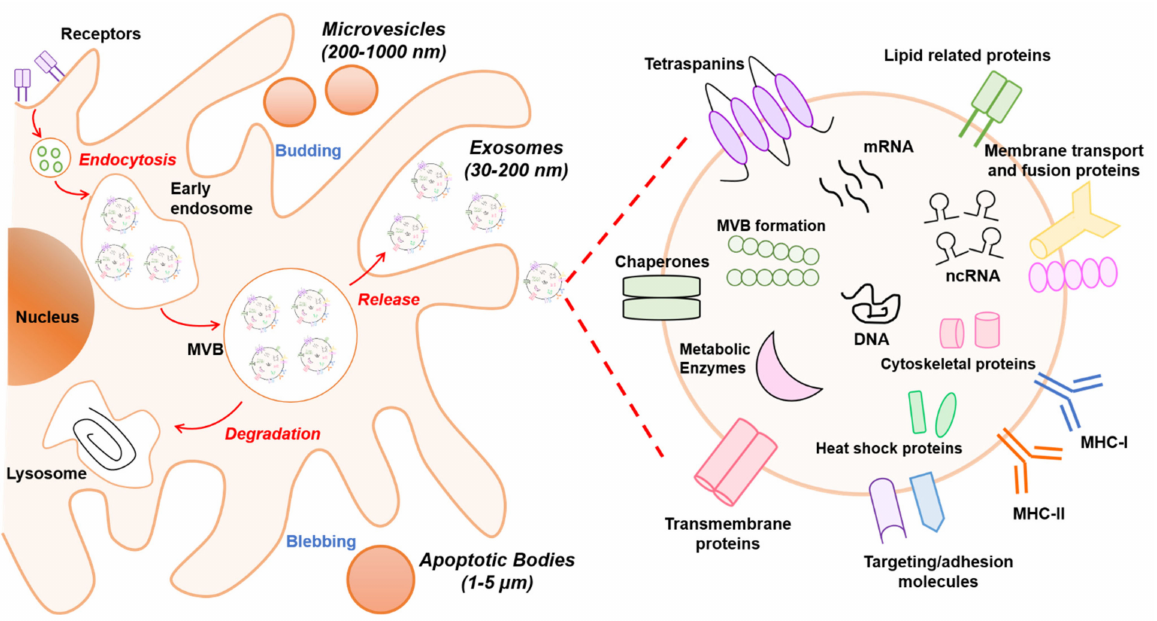
Figure 1. Schematic overview of extracellular vesicle (EV) biogenesis and cargo. At least three different subclasses of EVs are generated by eukaryotic cells: exosomes (30–200 nm), microvesicles (200–1000 nm), and apoptotic bodies (1–5 µ m). The left panel schematically shows the biogenesis pathway for each EV type. Microvesicles and apoptotic bodies sprout directly from the plasma membrane, whereas exosomes are generated within multivesicular body (MVB) subpopulations that upon maturation fuse with the plasma membrane. The biogenesis pathway influences the cargo of EVs. In particular, the composition of exosomes is presented in the right panel. Exosomes are rich in the adhesion molecules tetraspanins (CD9, CD81, CD63), antigen-presenting molecules (MHCI/II), membrane transport proteins (annexins, flotillin), enzymes (elongation factors, metabolic enzymes), and other cytosolic proteins (ribosomal proteins). In addition, lipids (sphingomyelin and phosphatidylserine) and nucleic acids (DNA, RNA, non-coding RNAs (ncRNAs), and micro-RNAs (miRNAs)) also are bioactive